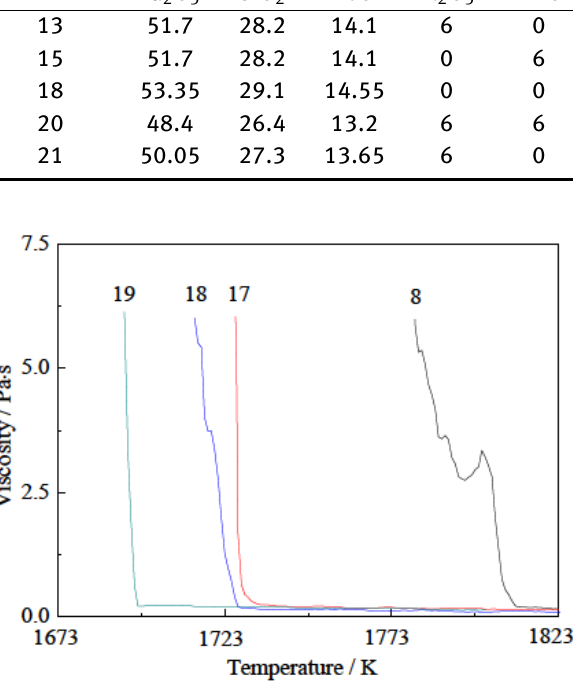
Figure 5: Viscosity curves of La 2 O 3 -SiO 2 -FeO-B 2 O 3